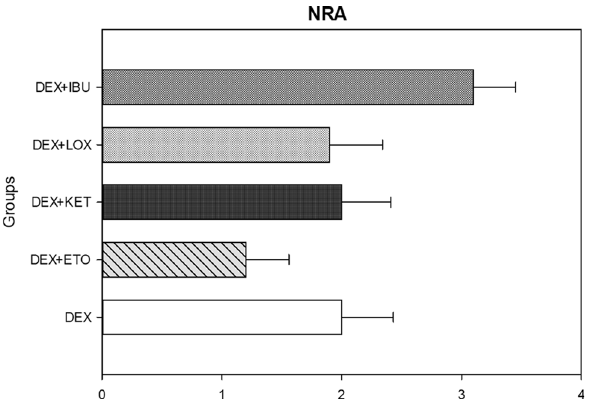
Figure 4. Chart regarding number of rescue analgesic consumption for 7 days postoperative. No significant difference was found for any comparison among groups ( P = 0.267; ANOVA test).